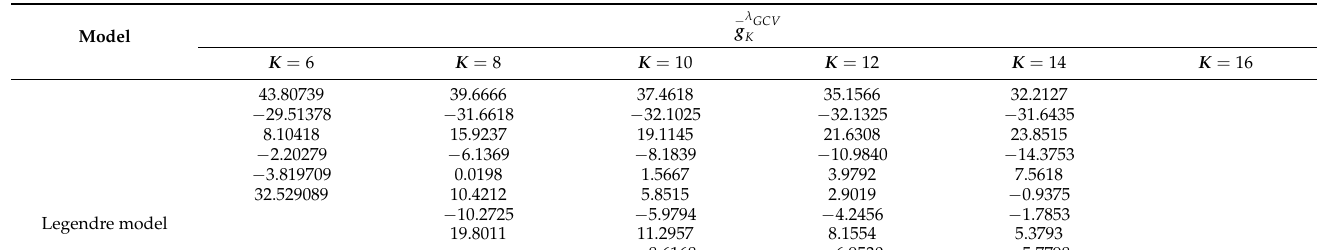
λ GCV − g are expressed in K